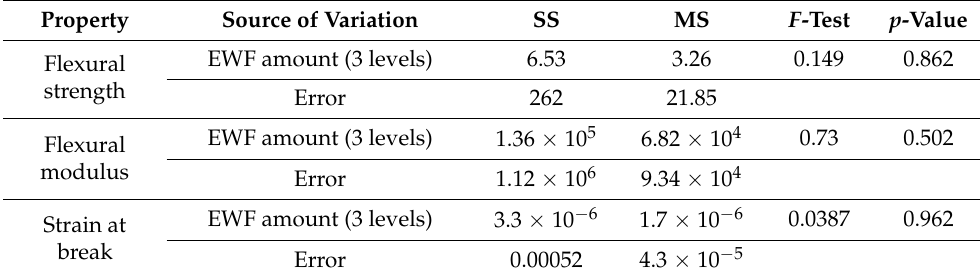
Table 6. ANOVA parameters—amount of EWF as the source of variation, neglecting the sample of commercial epoxy.